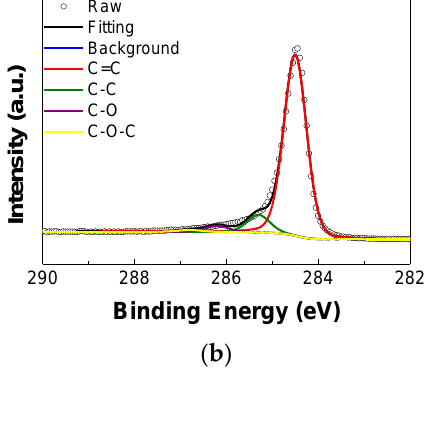
Figure 4. XPS survey scan spectra of graphite foil ( a ) without and ( b – d ) with He DBD jet treatment for ( b ) 30 s, ( c ) 1 min and ( d ) 3 min.